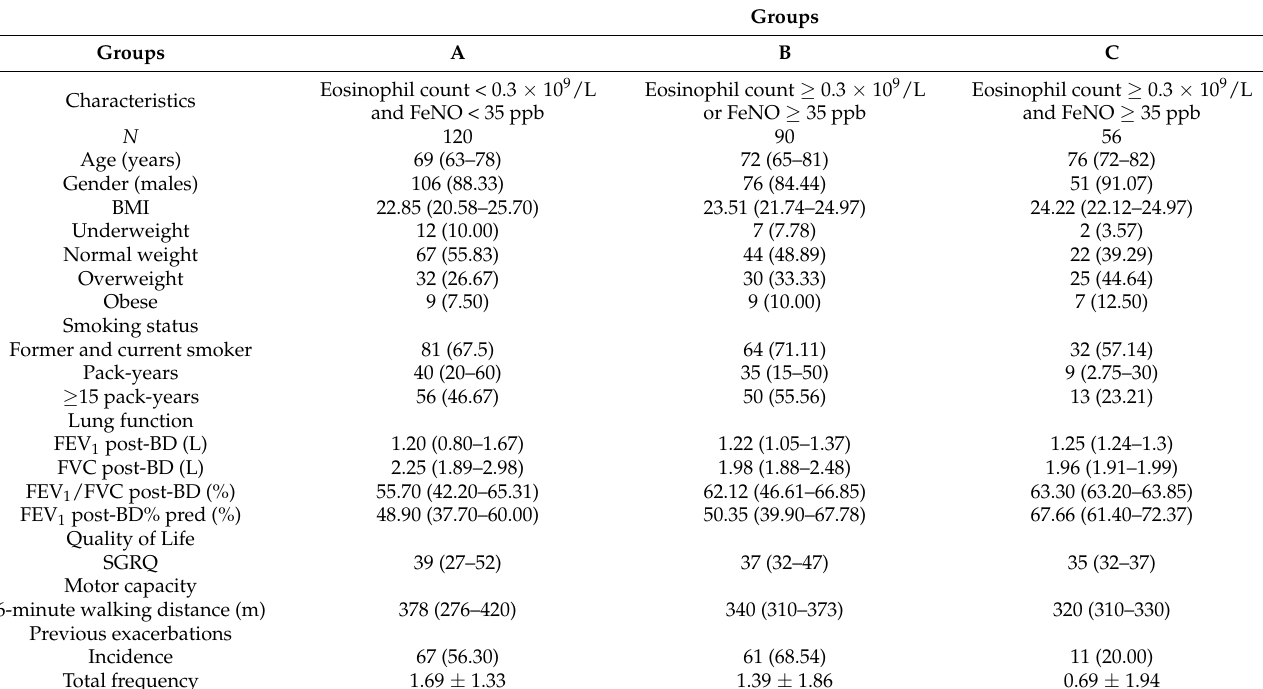
Table 2. Characteristics and classification of